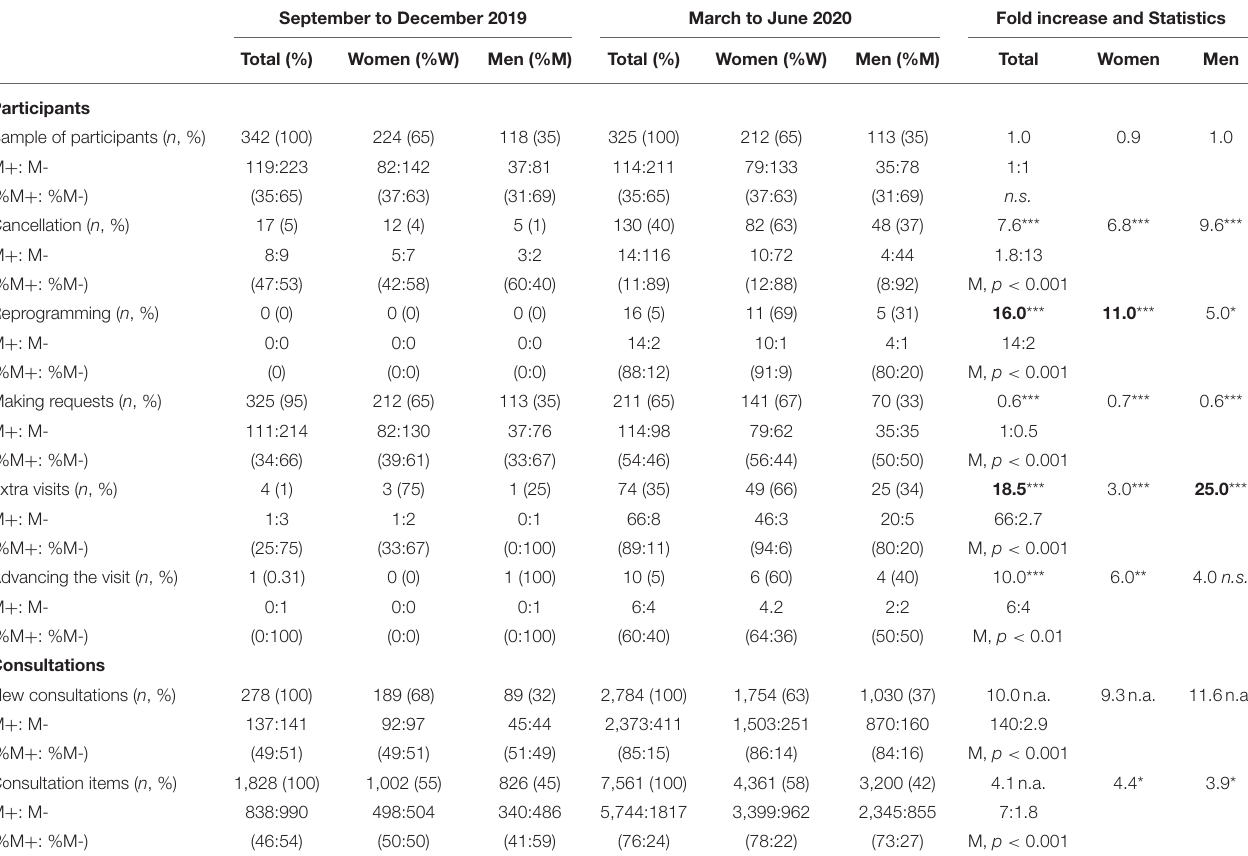
TABLE 1 | Results are expressed as total number and, in parenthesis, as the